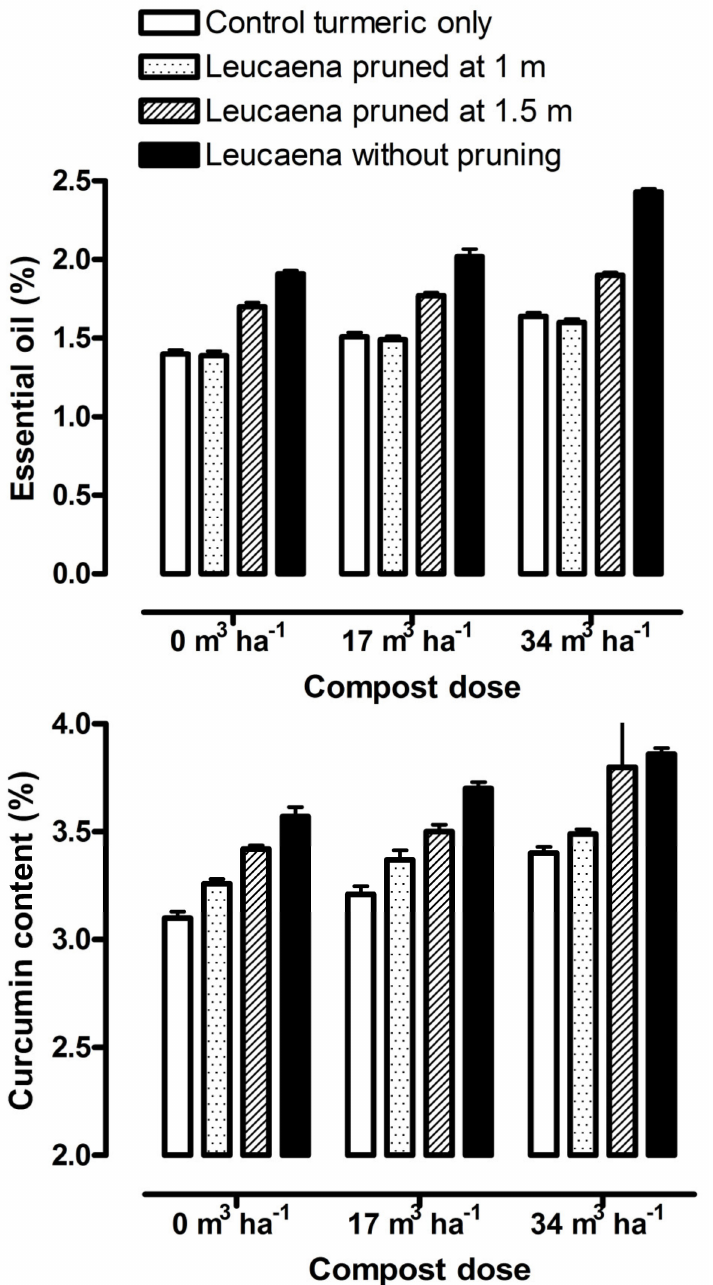
Figure 4. Essential oil (%) and curcumin (%) in rhizomes in of Curcuma longa in response to alley-cropping and organic-compost treatments as pooled data of the two seasons of 2021 and